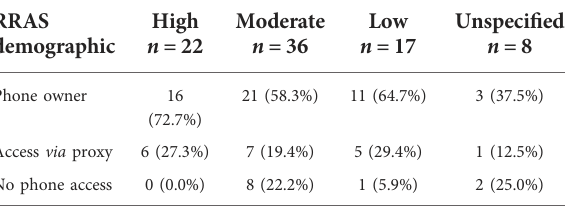
TABLE 3 Distribution of phone ownership/access by readmission risk assessment score.